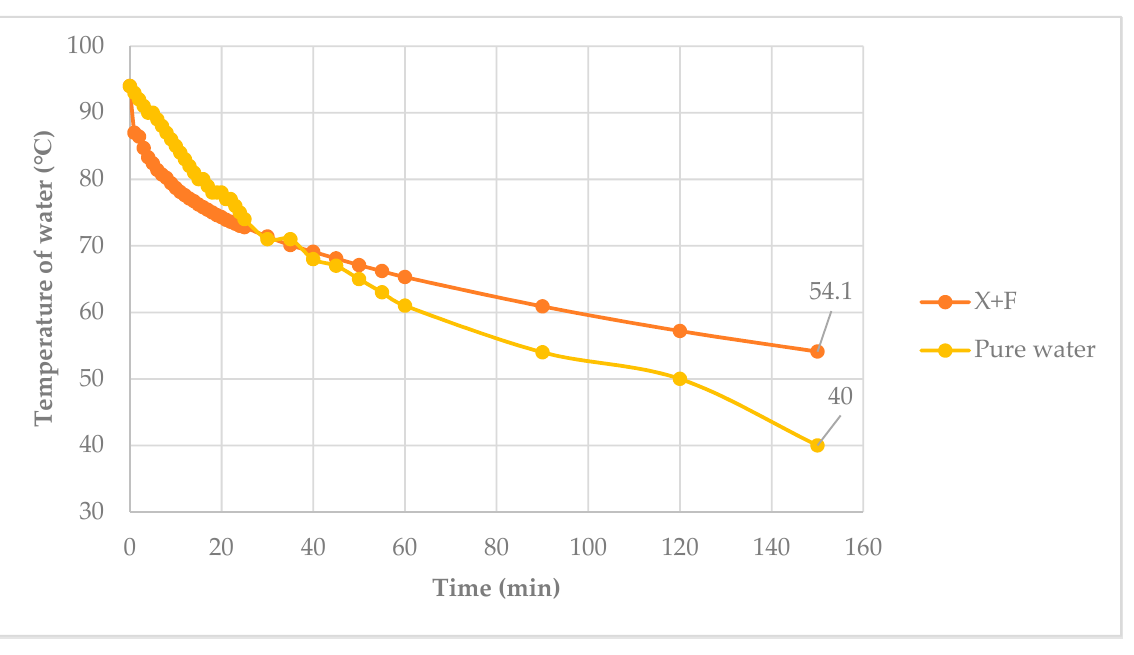
Figure 15. Water temperature vs. time .